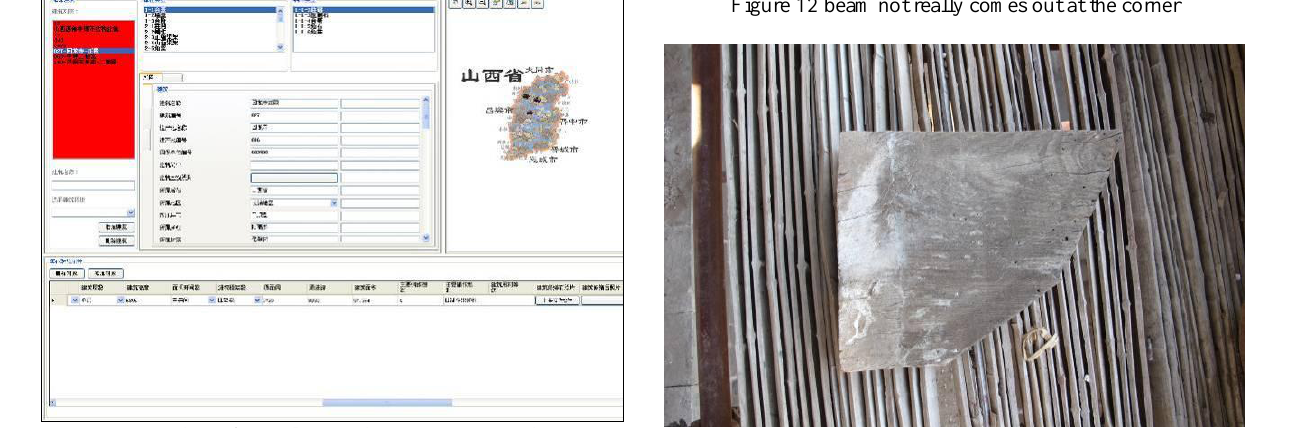
Figure 10 Database for Early Wooden Construction, data input page.